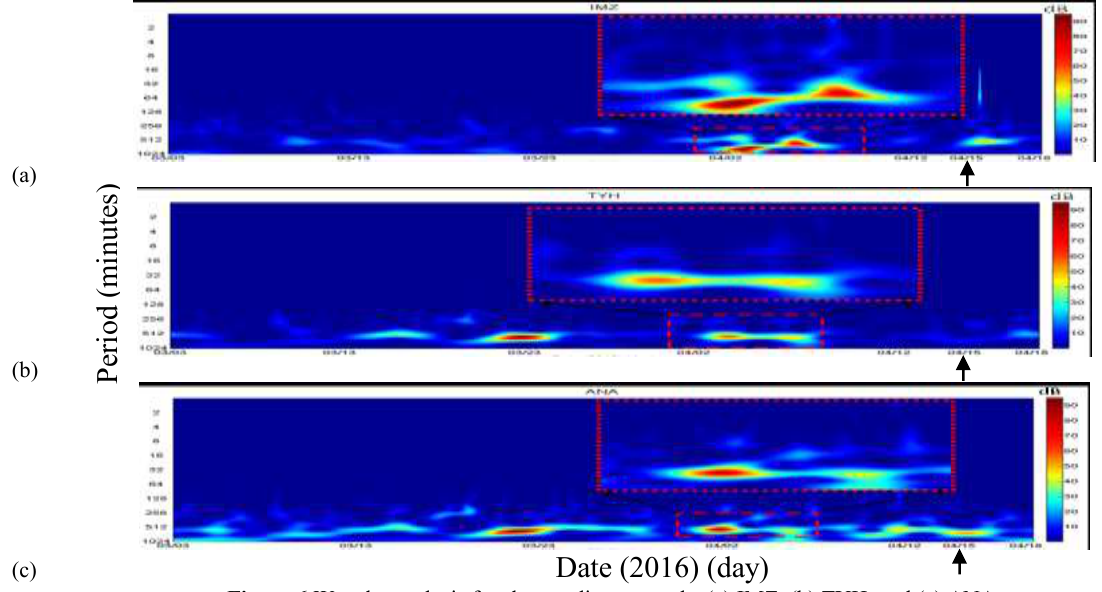
Figure 6 Wavelet analysis for shorter-distance paths (a) IMZ, (b) TYH, and (c)